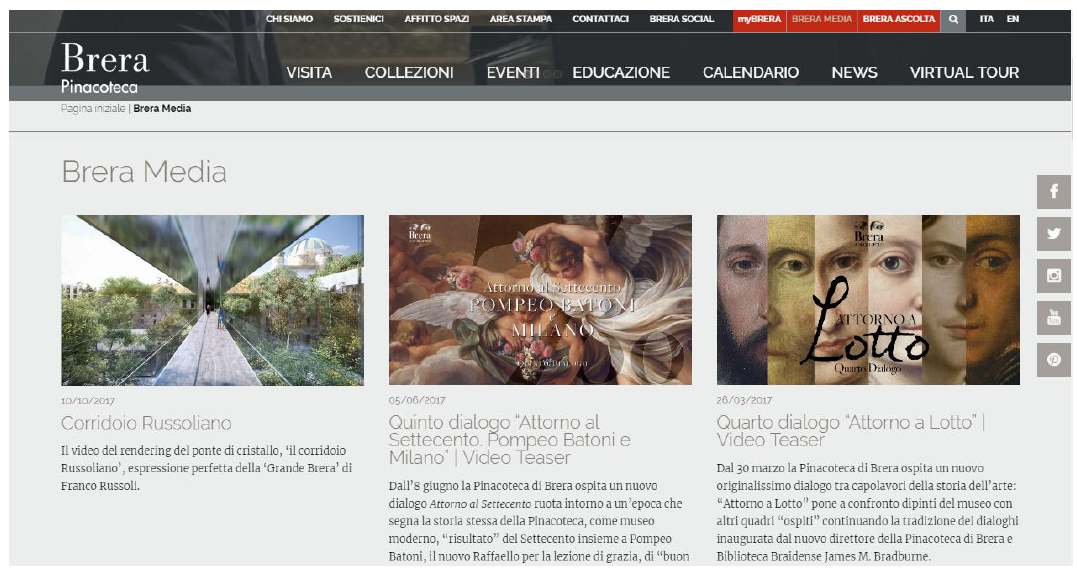
Figure 2. Brera Media, Brera Art Gallery of Milan, website.